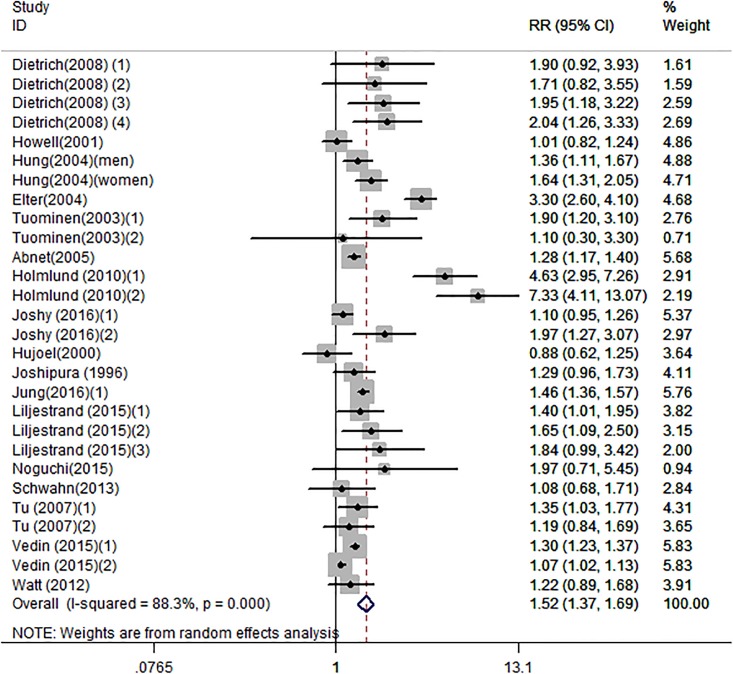
Forest plots for meta-analysis of tooth loss and risk of cardiovascular disease.